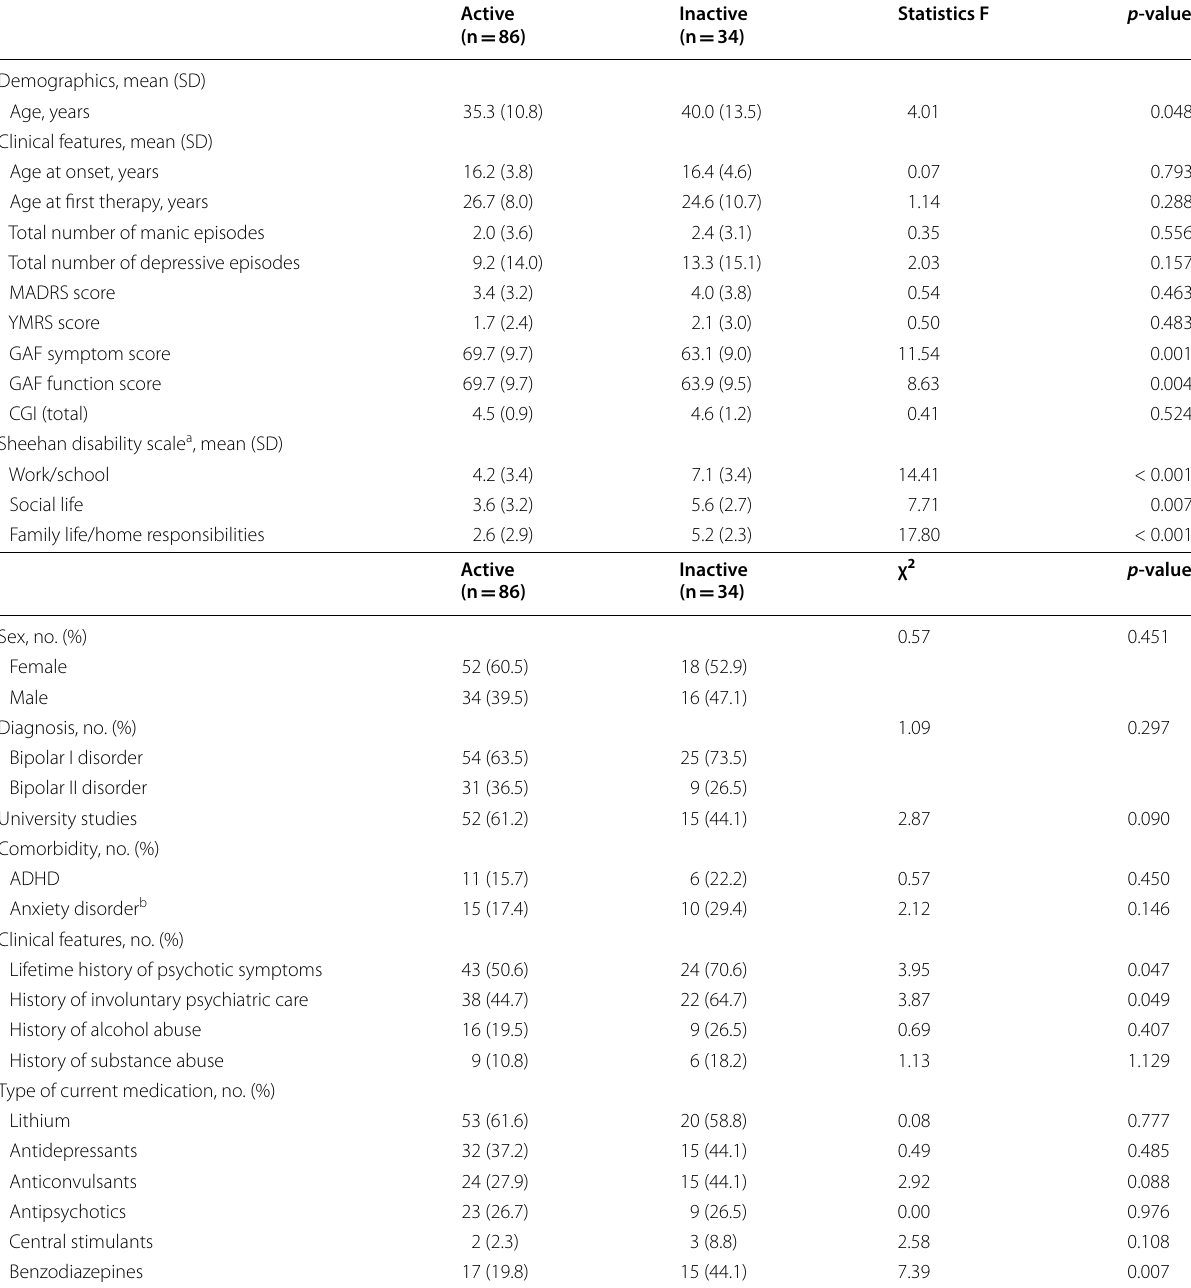
Table 1 Demographic, clinical, functional, and pharmacological